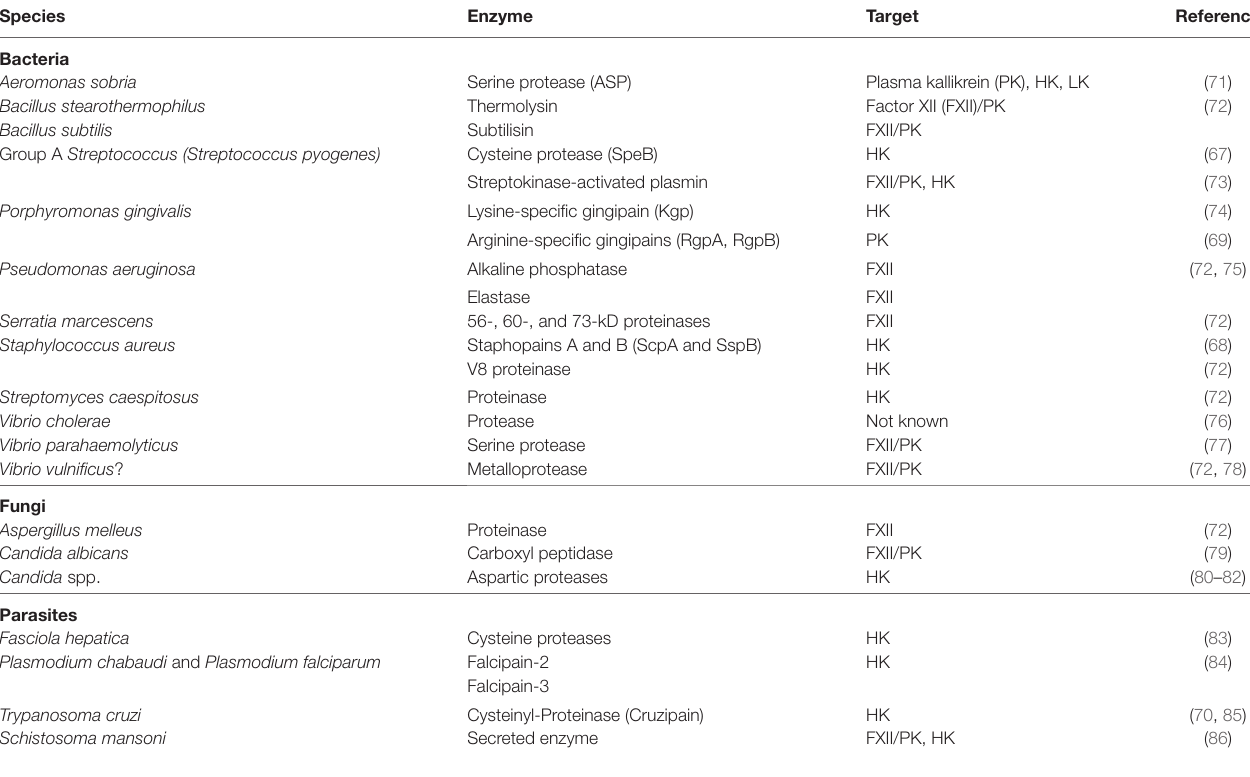
TABLe 1 | Enzymes produced by pathogens that activate or cleave contact factors.